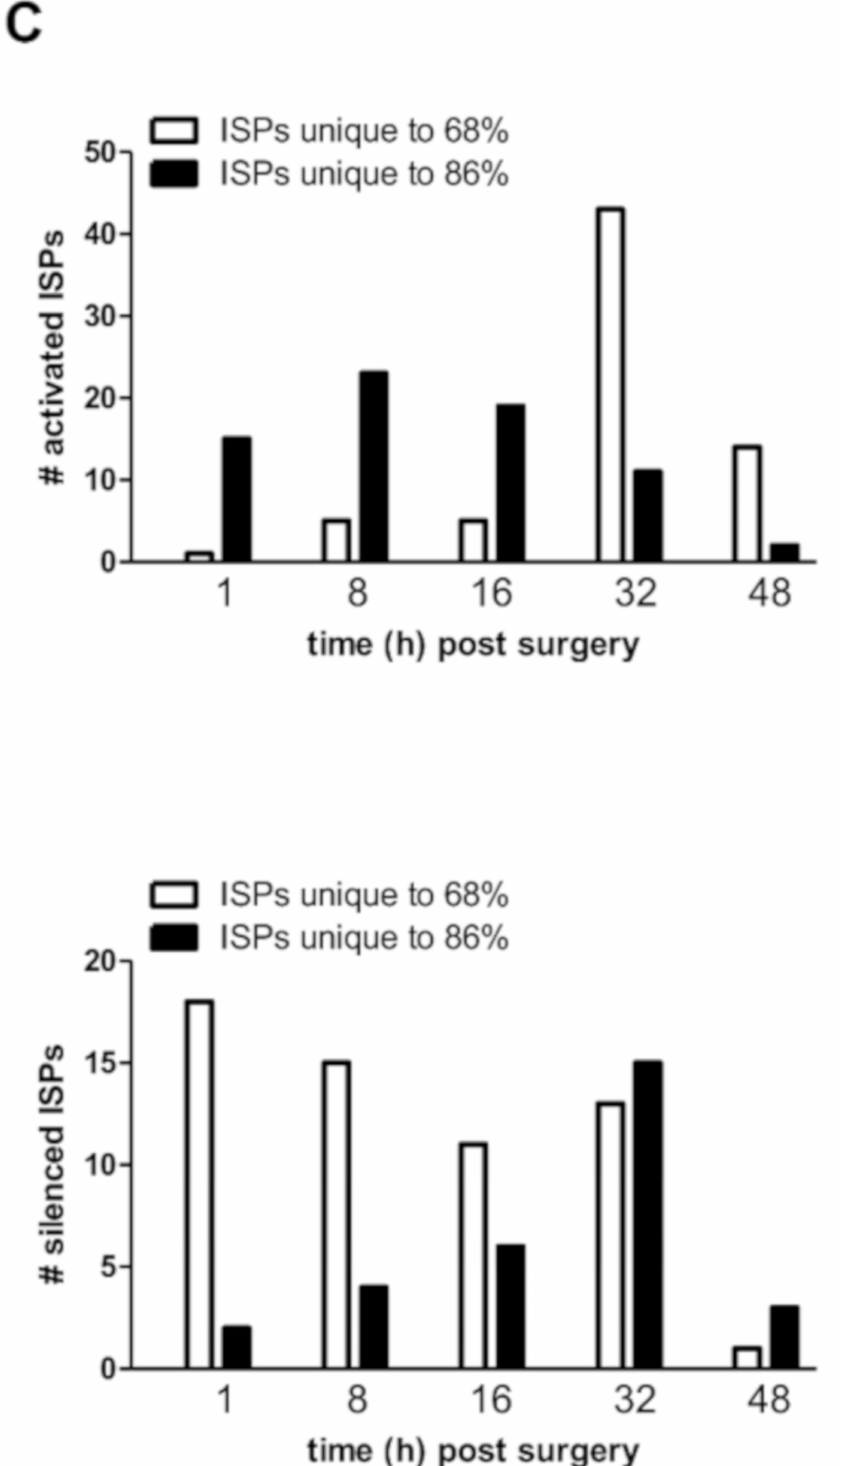
Figure 2. Modulation of intracellular signaling pathways (ISPs) after nHx and eHx. ( A ) Hierarchical clustering heatmap 32 h post-surgery based on the analysis of 271 intracellular signaling pathway activation profiles. Color key represents PAS score for a given pathway in a given sample. ( B ) Results of the principal component analysis. Groups were analyzed according to their PAS score signatures calculated for 271 intracellular signaling pathways. Black dots denote nHx samples; grey denote eHx samples. ( C ) Number of unique, activated ISPs after nHx and eHx at 1, 8, 16, 32, and 48 h post-surgery (top); Number of silenced ISPs after nHx and eHx at 1, 8, 16, 32, and 48 h post-surgery